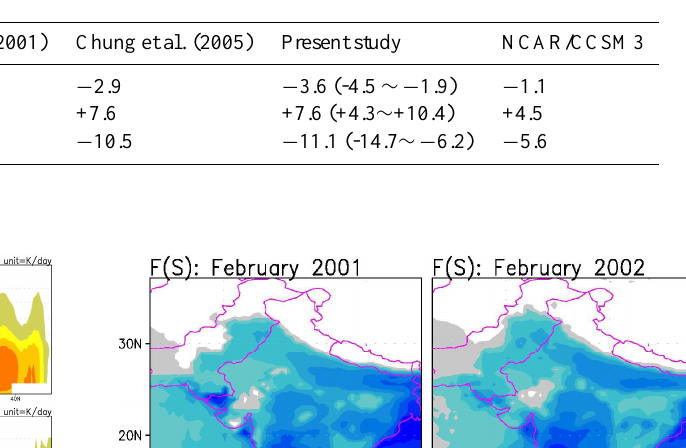
Table 2. Anthropogenic aerosol radiative forcing averaged over the INDOEX domain (40–100 ◦ E and Equator–20 ◦ N) for the January– March period. The forcing estimate for the year 1999 from the INDOEX (Indian Ocean Experiment) is shown along with Chung et al. (2005) estimate for 2001–2003, the present study’s estimate for 2001–2004 and the CCSM calculation. For the present study’s estimate, we also show the range from an estimate for each year.